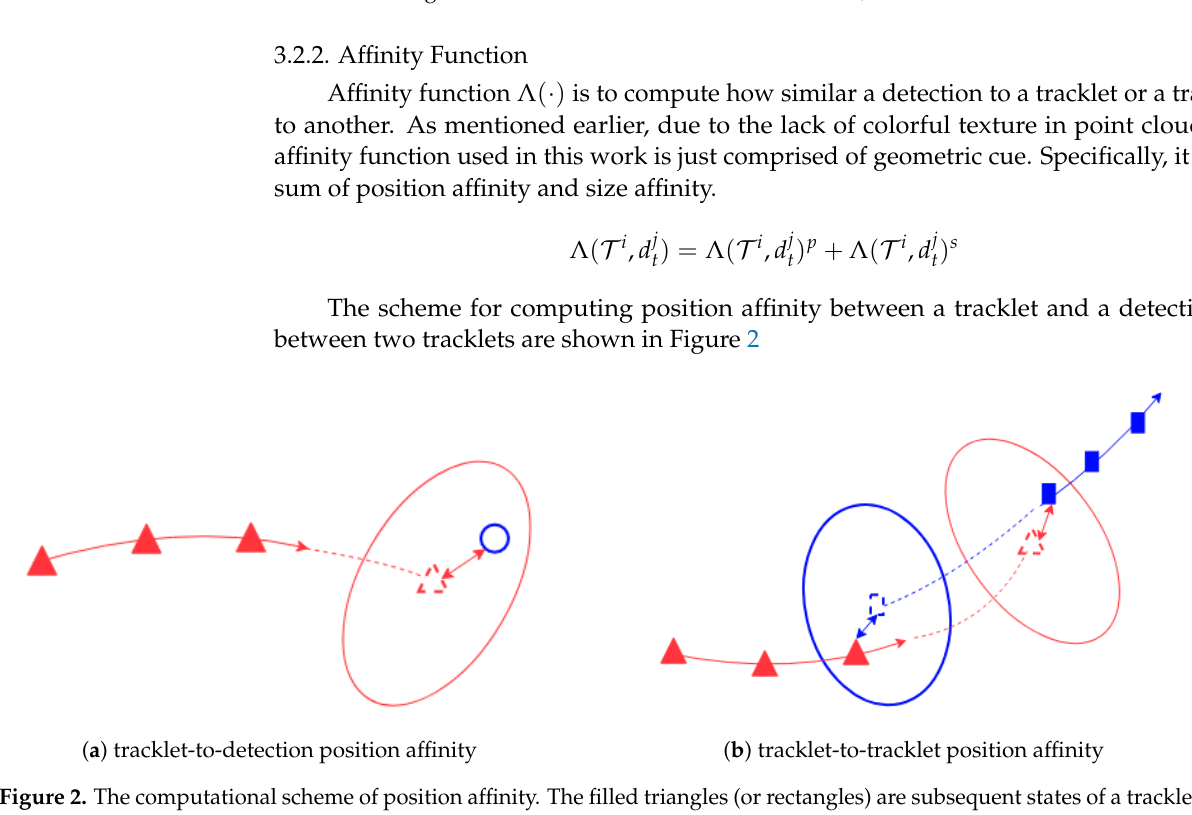
. Then, global association stage matches each 0: t